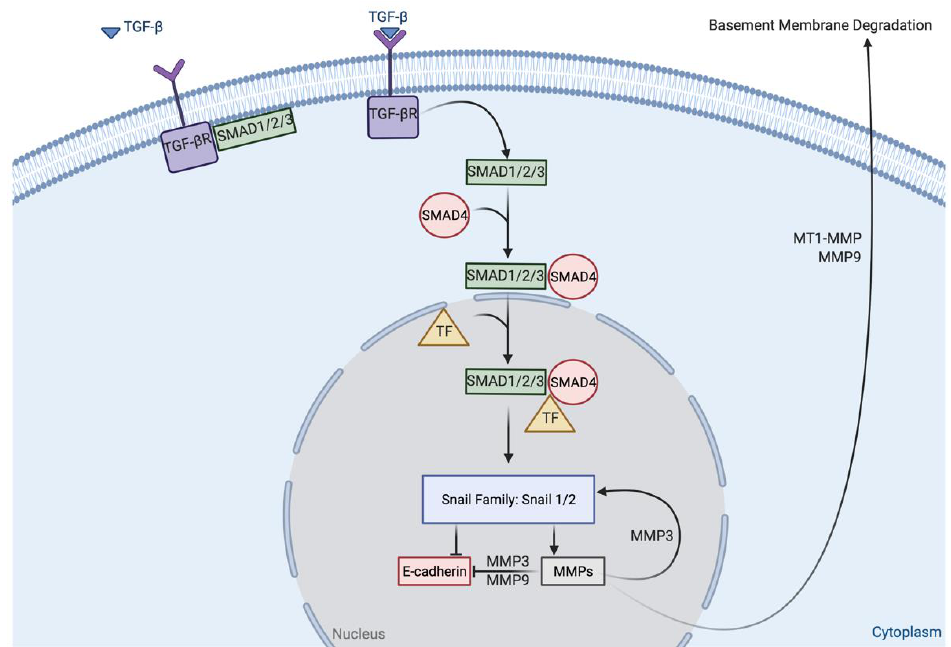
Figure 1. The role of TGF- β in EMT and metastasis. When TGF- β binds to its receptor, SMAD1/2/3 are released into the cytoplasm, where they bind to SMAD4. In the nucleus, the SMAD complex binds to transcription factors (TF) that upregulate the Snail family. Snail1/2 promote MMP production and downregulate E-cadherin. MMP-9 and MMP-3 degrade E-cadherin, reducing the amount of functional E-cadherin available to the cell. MMP-3 also promotes Snail family upregulation in a positive feedback loop. MT1-MMP and MMP-9 degrade the basement membrane, further promoting EMT and metastasis. Figure adapted from [33,51,52]. Both MMP-3 and MT1-MMP were also shown to influence EMT. MMP-3 was deter- mined to help promote EMT through upregulation of the Snail family transcription factors [21]. MMP-3 was also shown to bind and cleave E-cadherin as a substrate resulting in decreased cell–cell adhesion [54]. Comparatively, MMP-3 and MMP-9 exhibit many of the same effects on expression and EMT. MT1-MMP is expressed in metastatically active OvCa cells [24]. In gastric cancer, MT1-MMP is shown to upregulate EMT proteins includ-